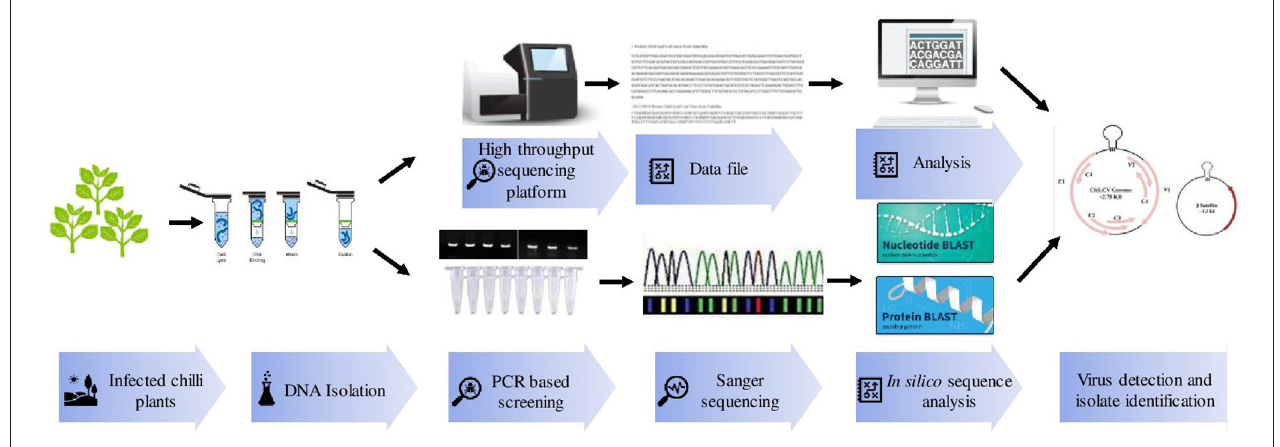
FIGURE 2 | Various molecular techniques used for detection and identification of Chili leaf curl virus (ChiLCV) infecting